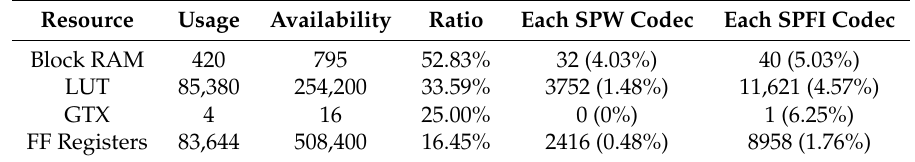
Table 1. Implementation results on the target NI PXIe-6591R Kintex-7 FPGA, system reference configuration.